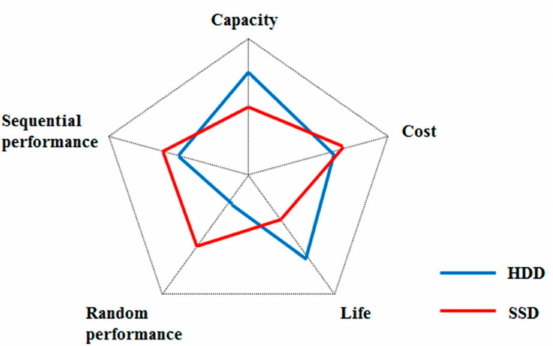
Figure 2. Comparison between solid-state drive (SSD) and hard disk drive